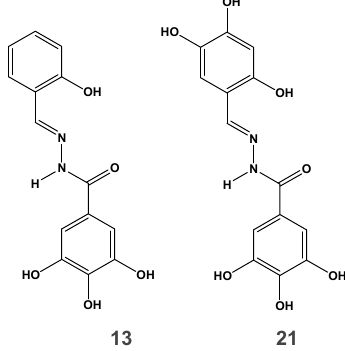
Figure 1. Structure of N -acylhydrazone analogs .